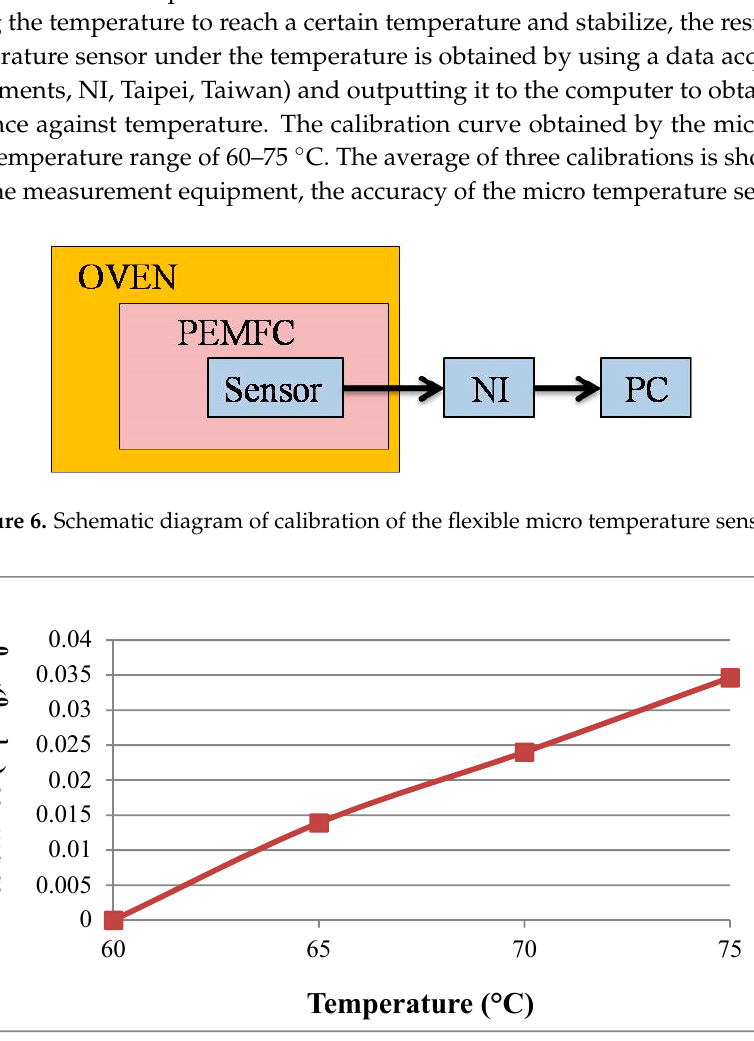
Figure 7. Calibration curves of the micro temperature sensors.